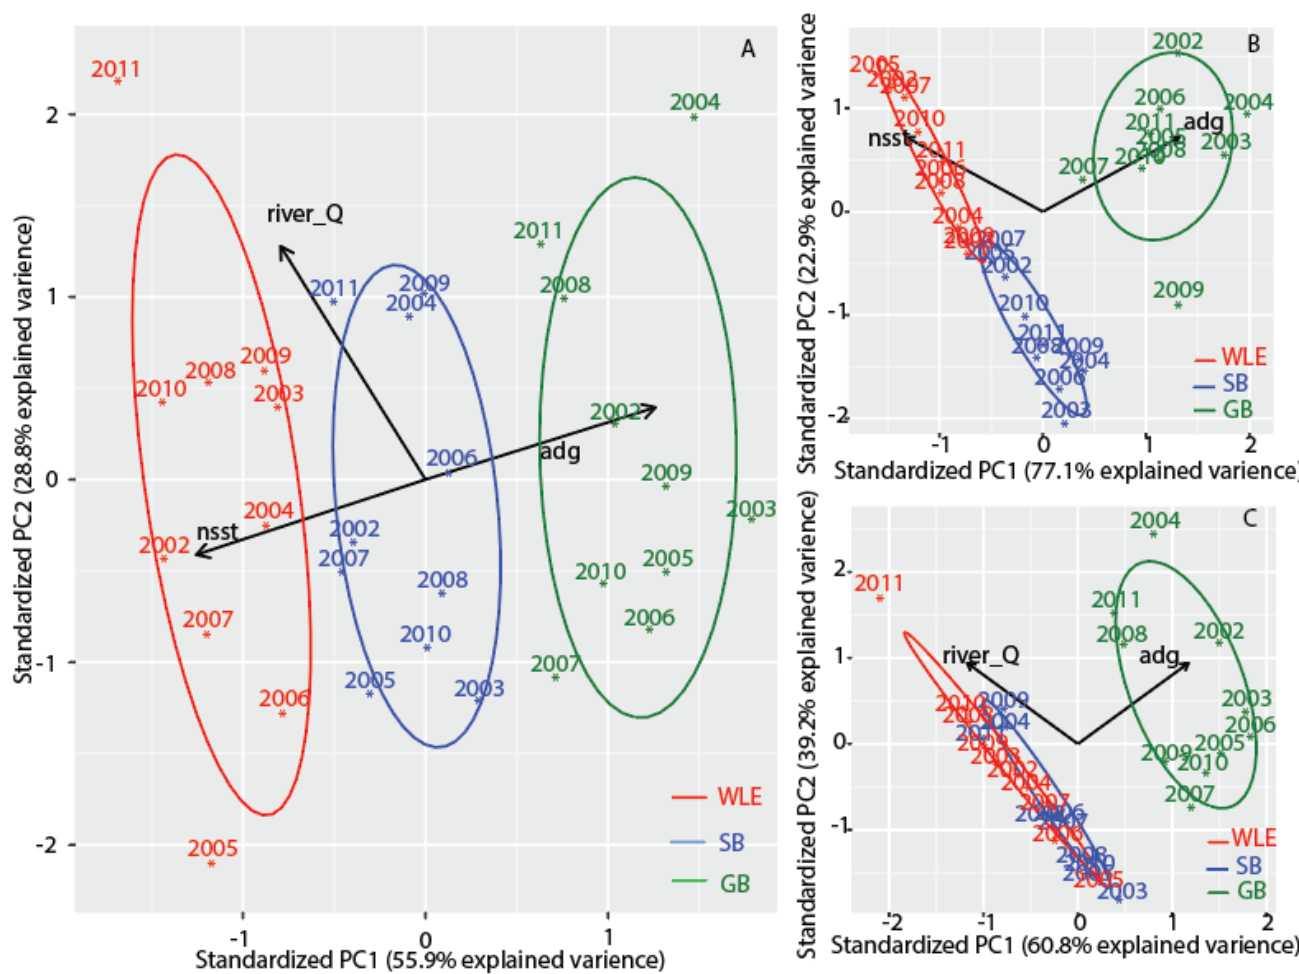
Figure 8. Principal Components Analysis (PCA) by year (2002–2011) for each basin. Three-parameter PCA for Green Bay (red), western Lake Erie (green), and Saginaw Bay (blue) ( A ) using night sea surface temperature (nsst), river discharge (river_Q) from each of the three respective rivers (Maumee River, Saginaw River, and Fox River), and gelbstoff absorption. Two-parameter PCA for each basin using either nsst/adg ( B ) or adg/river_Q ( C ) also for Green Bay (red), western Lake Erie (green), and Saginaw Bay (blue).